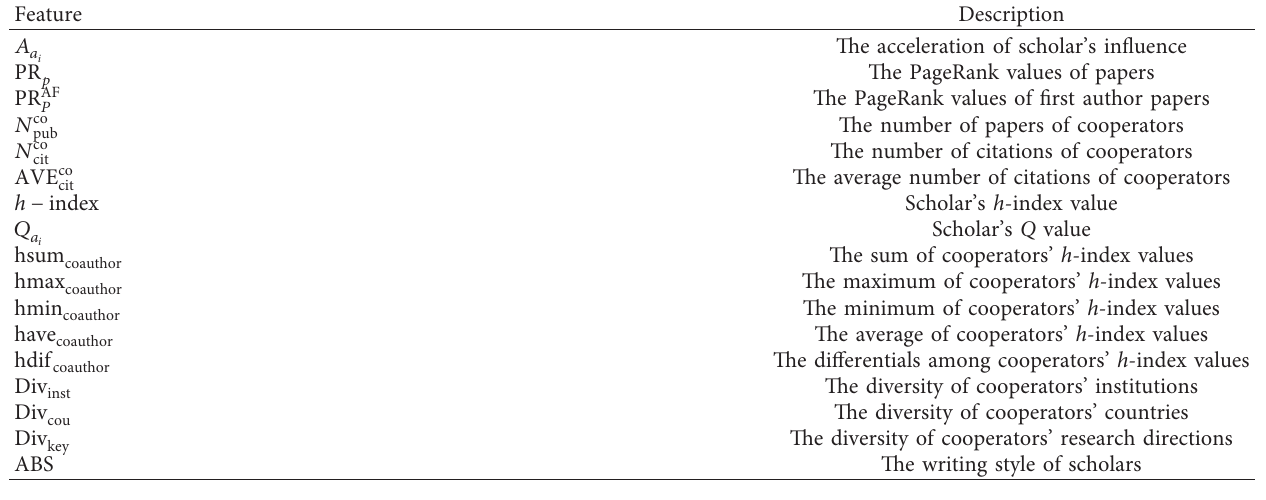
Table 2: Complex factor descriptions.